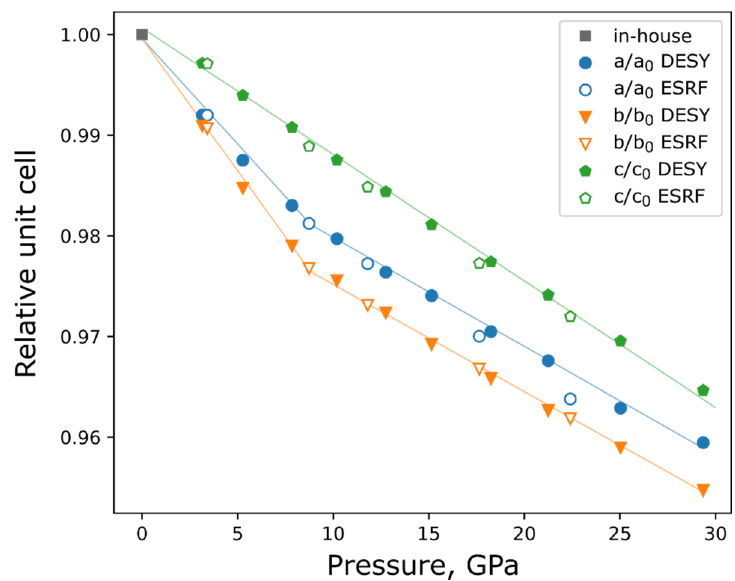
Table 3. Refined parameters for the δ -AlOOH equation of state.